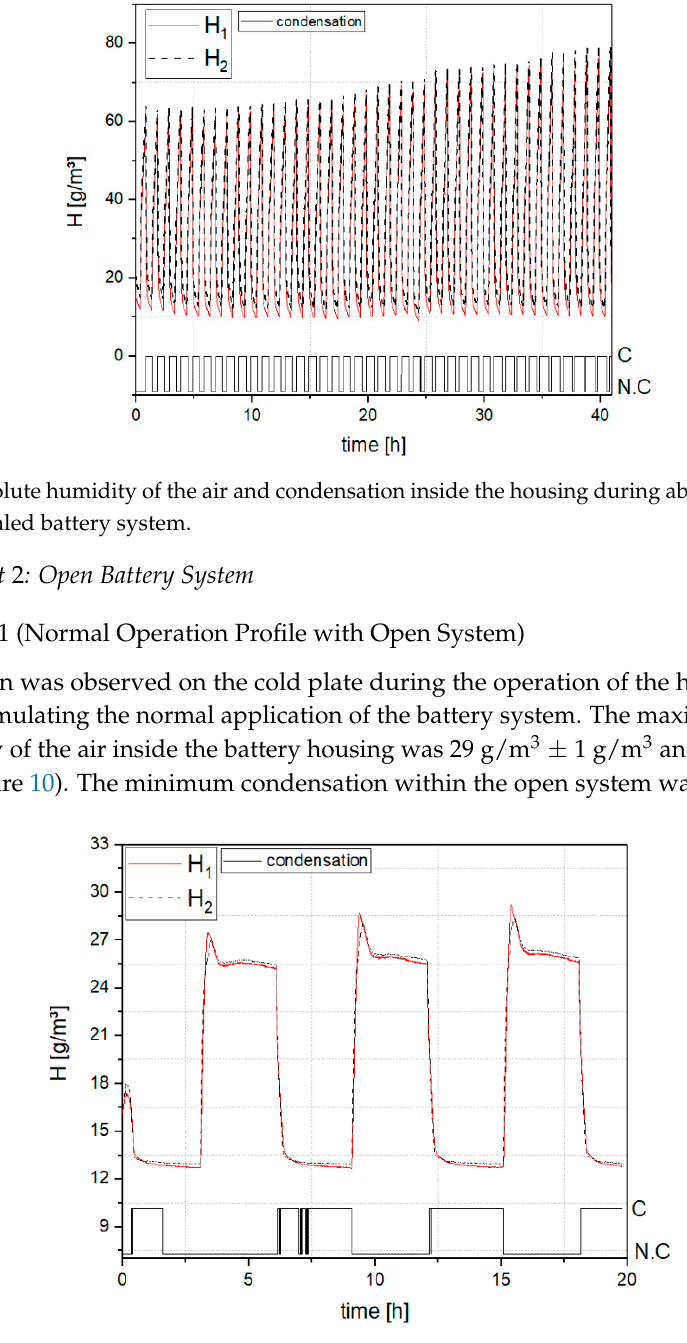
Figure 10. Absolute humidity and condensation measurements for the open battery system during normal operation.